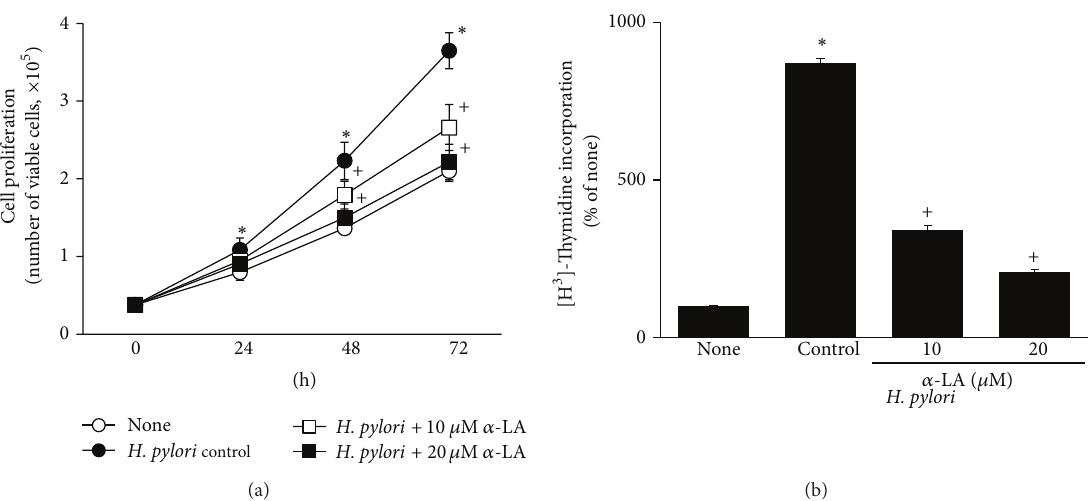
Figure 3: Effect of 𝛼 -LA on cell proliferation of H. pylori- infected AGS cells. The cells were pretreated with 𝛼 -LA for 2 h and cultured in the presence or absence of H. pylori . Cell proliferation was assessed by viable cell numbers and [ 3 H ] thymidine incorporation. (a) Viable cell numbers were determined by trypan blue exclusion assay for the indicated time period. (b) The cells were treated with [ 3 H ] thymidine at 24 h after H. pylori infection and incubated for 8h. The amount of [ 3 H ] thymidine incorporation of AGS cells cultured in the absence of H. pylori is considered as 100%. ∗ 𝑃 < 0.05 versus corresponding none (the cells cultured in the absence of H. pylori ); + 𝑃 < 0.05 versus corresponding H. pylori control (the cells cultured in the presence of H. pylori and treated without 𝛼 -LA).